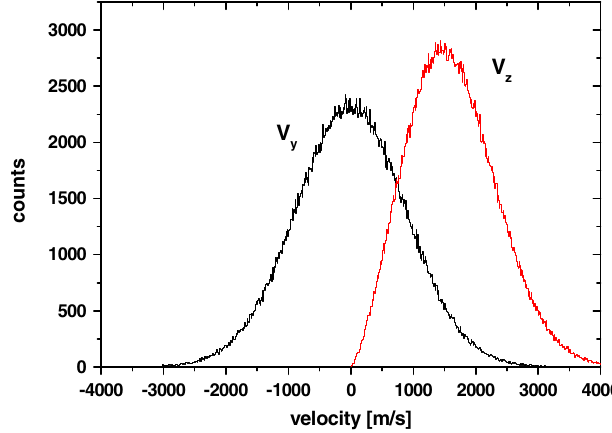
FIG. 8. (Color) Velocity distributions in y and z directions of the neon ions that are lost at the plasma electrode.